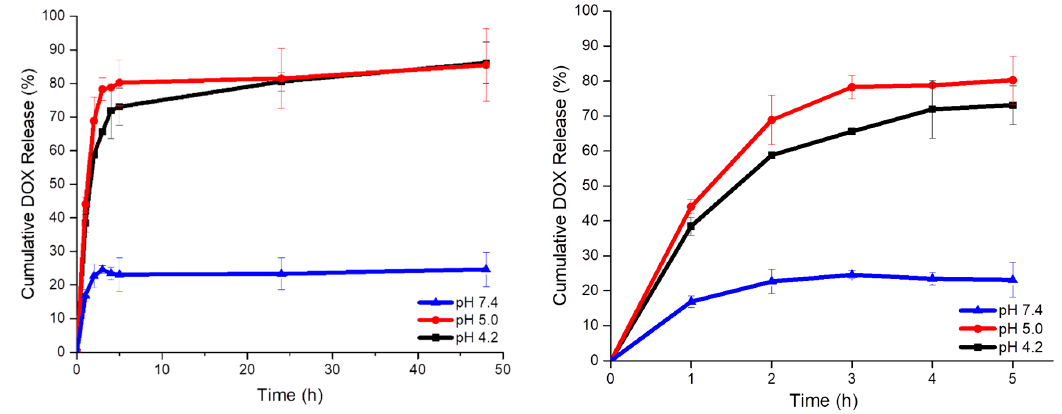
Figure 6. Doxorubicin release over time from loaded Fe 3 O 4 @ ĸ CRG carriers, at 37 °C and variable pH